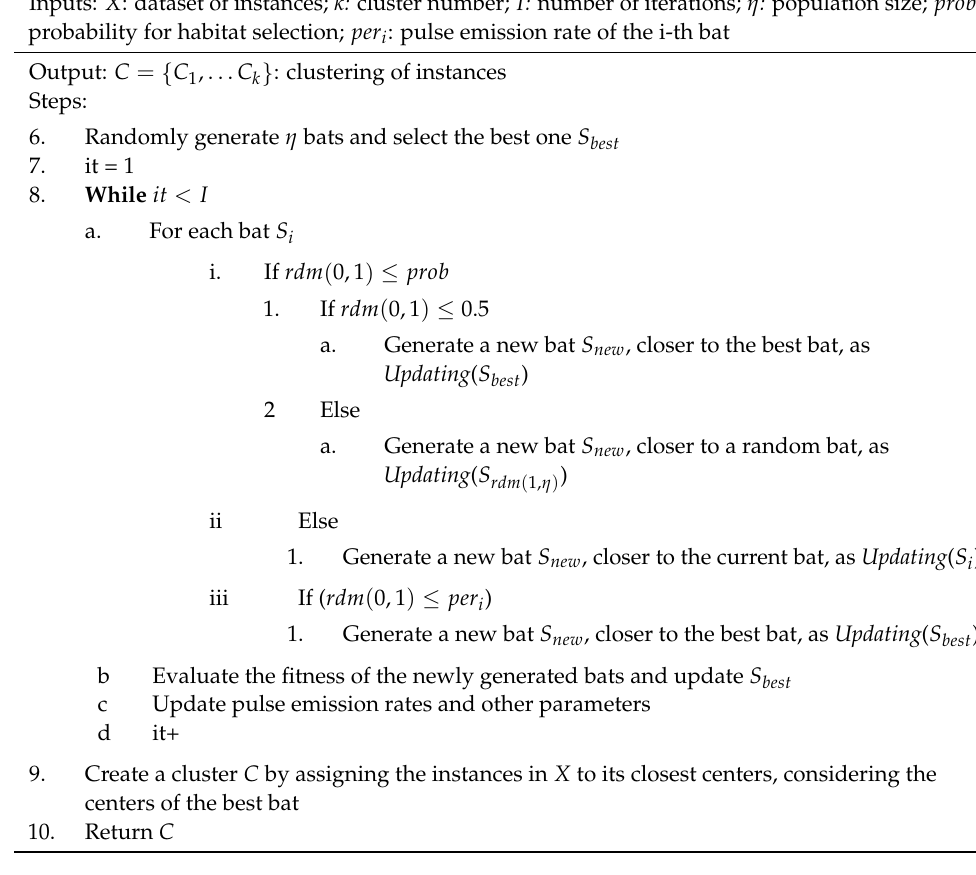
Algorithm 7. Pseudo code of the CNBA algorithm to clustering mixed data. CNBA mixed clustering